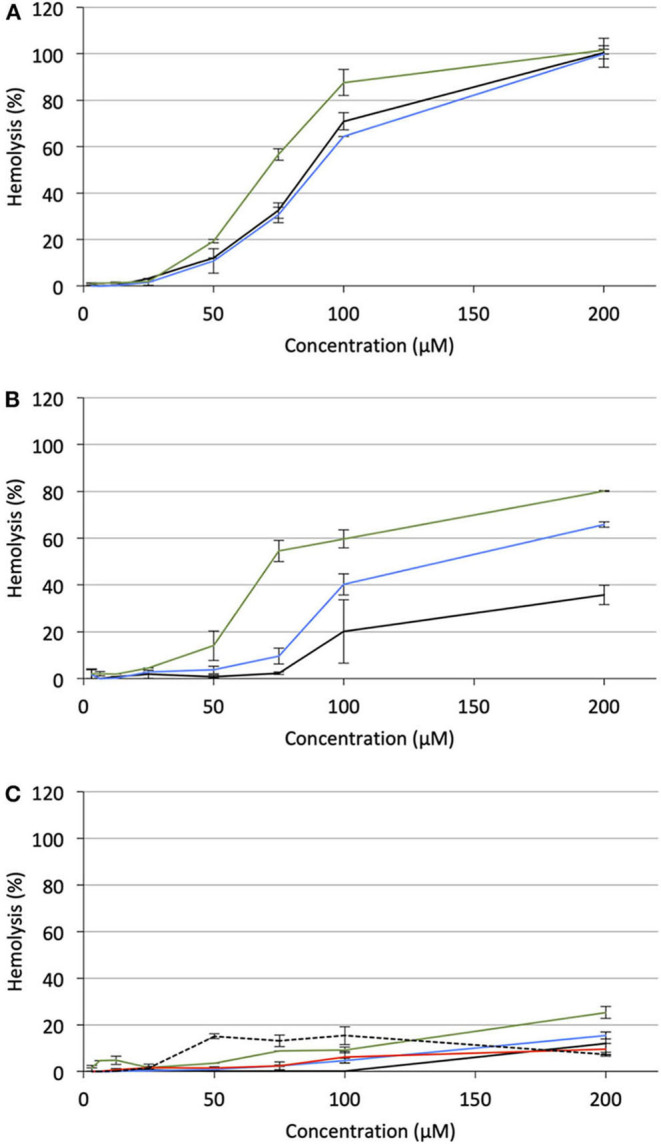
Hemolytic effect of pro-APL compounds on sheep RBC incubated at 37°C for 24 h, as a function of the prodrug concentration. (A) Pro-miltefosine series (M12: black; ME12: blue; M E′12: green). (B) Pro-perifosine series (P12: black; PE12: blue; P E′12: green). (C) Pro-erufosine series (E12: black; EE12: blue; E E′12: green; EC12: red; E C′12: dashed).